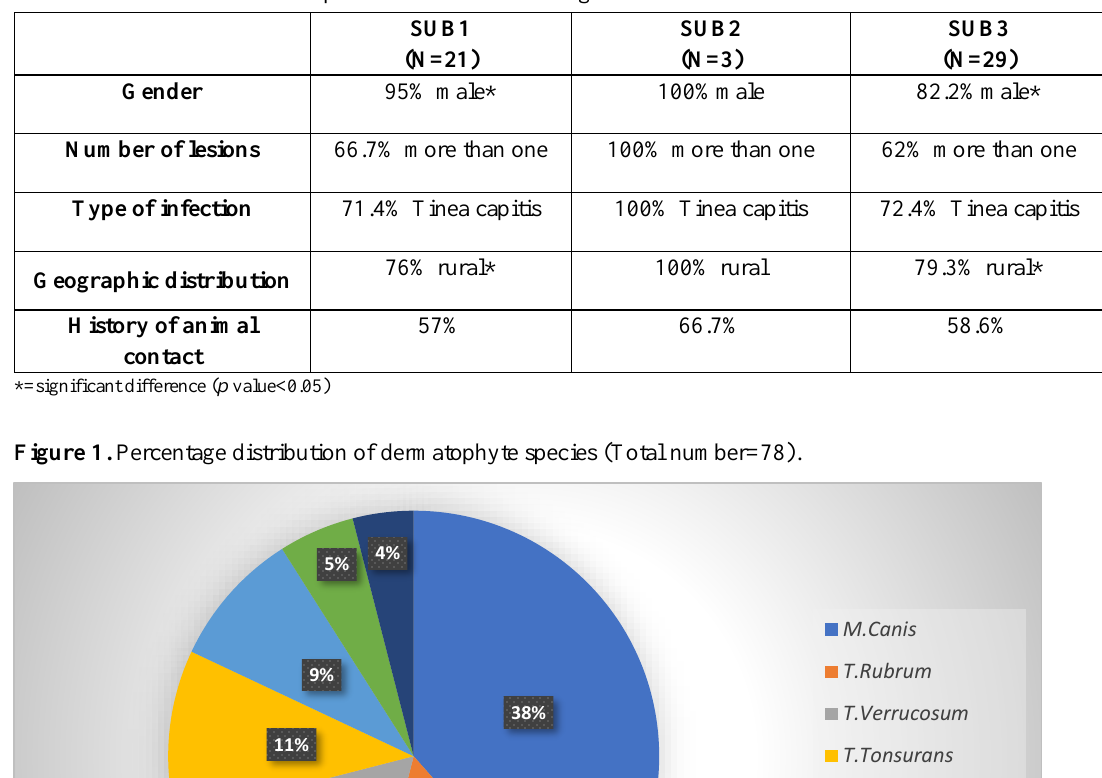
Table 2. Relation between the positive isolates for SUB genes and their clinical data.